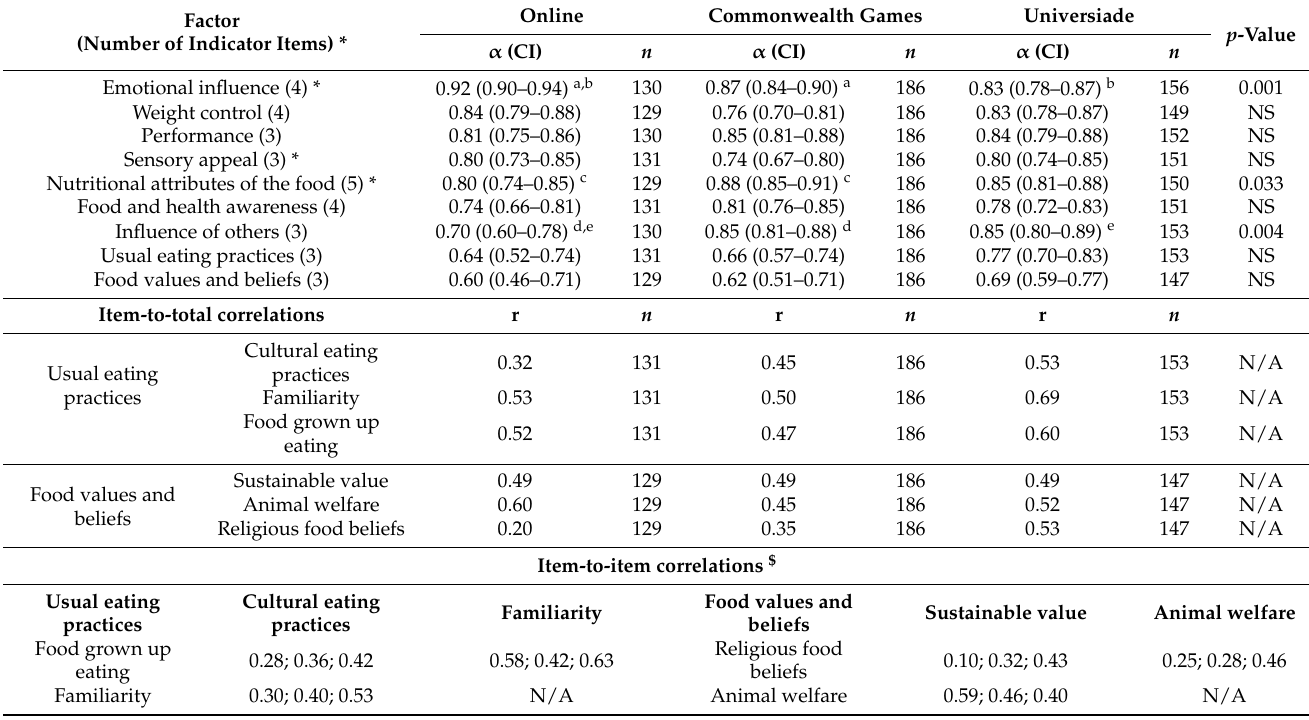
Table 4. Comparison across three independent samples of the internal consistency scores for nine Athlete Food Choice Questionnaire factors (Cronbach’s alpha coefficients) and item correlation coefficients for two